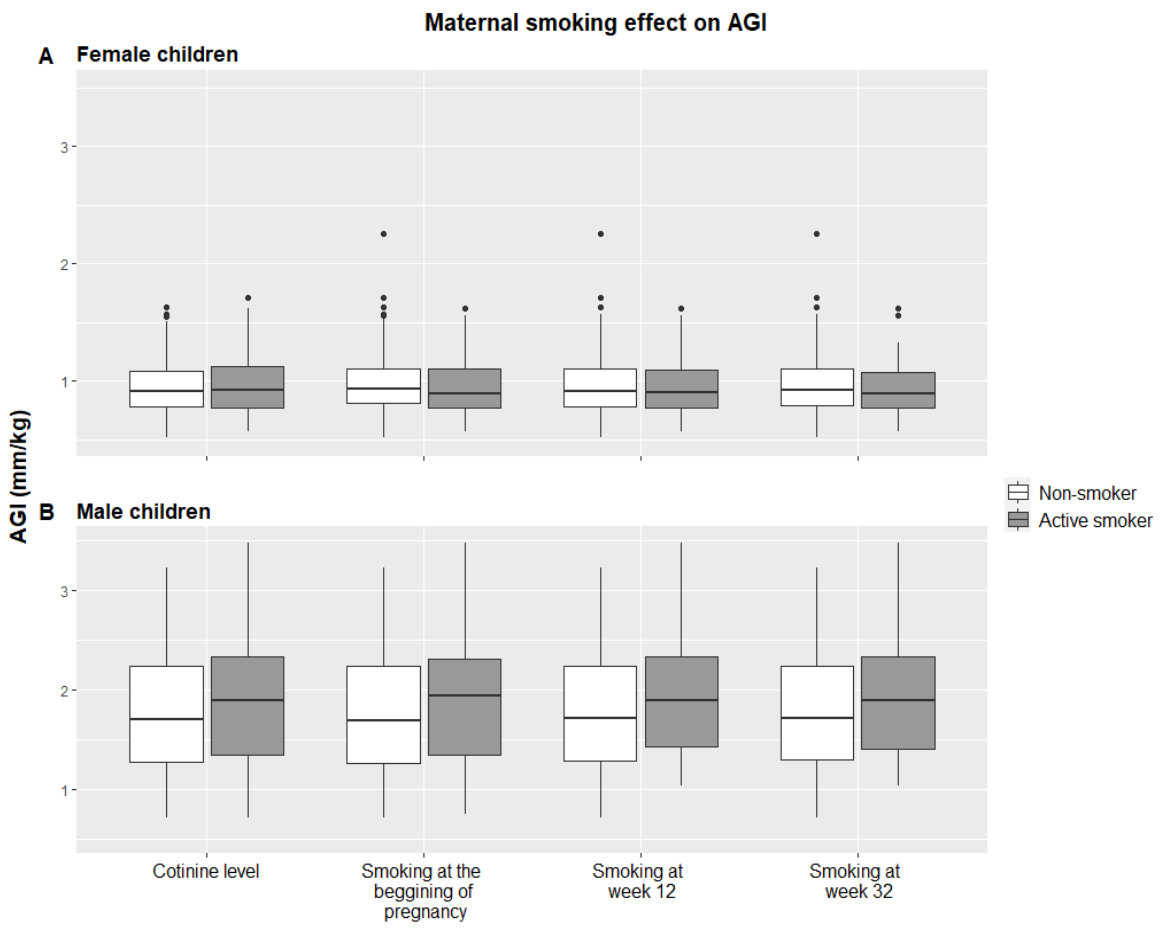
Figure 2. The effect of maternal smoking and anogenital distance in children from the INMA–Asturias cohort at 4 years.